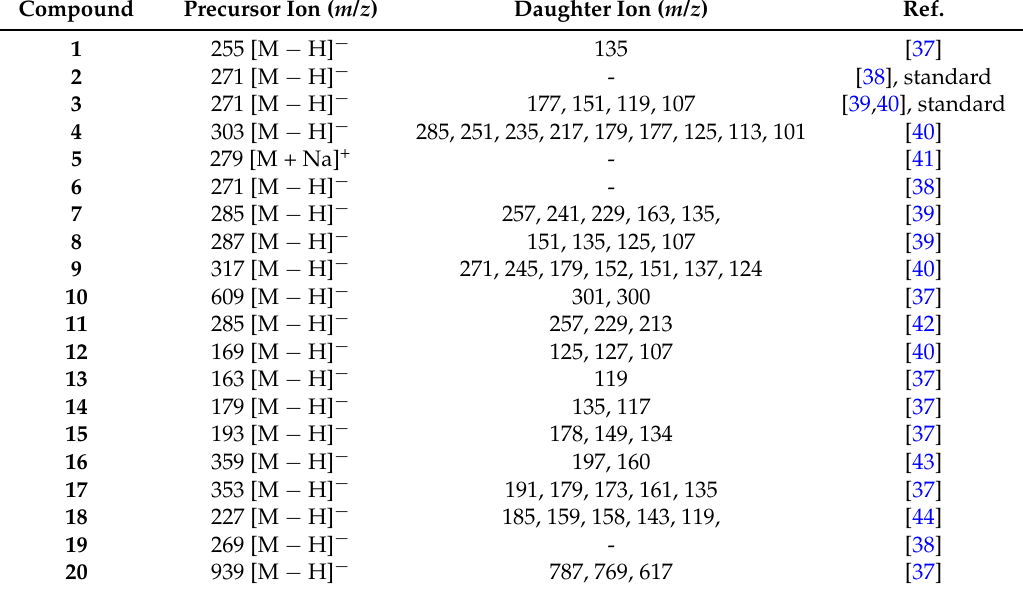
Table A3. LC-MS product ions Compounds 1 – 20 .